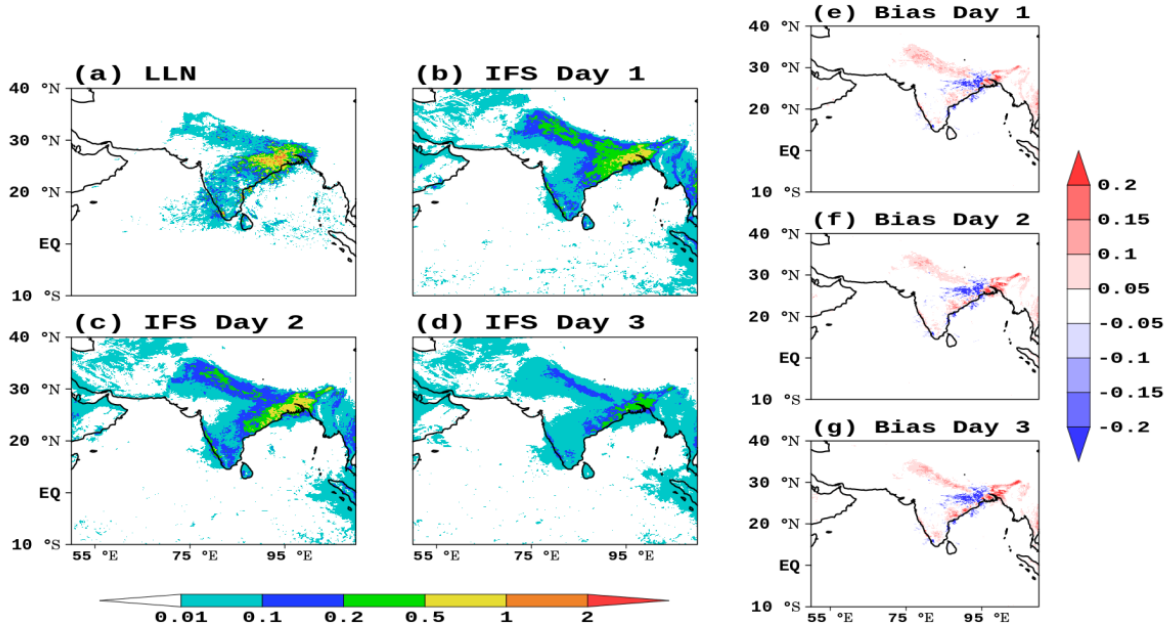
Figure 4. MAM 2020 mean flash density (flash count km − 2 day − 1 ) ( a ) observed by LLN and forecasted by IFS for ( b ) Day 1, ( c ) Day 2, and ( d ) Day 3 lead times. ( e – g ) shows the forecast bias (flash count km − 2 day − 1 ) for Day 1, Day 2, and Day 3 lead times, respectively.